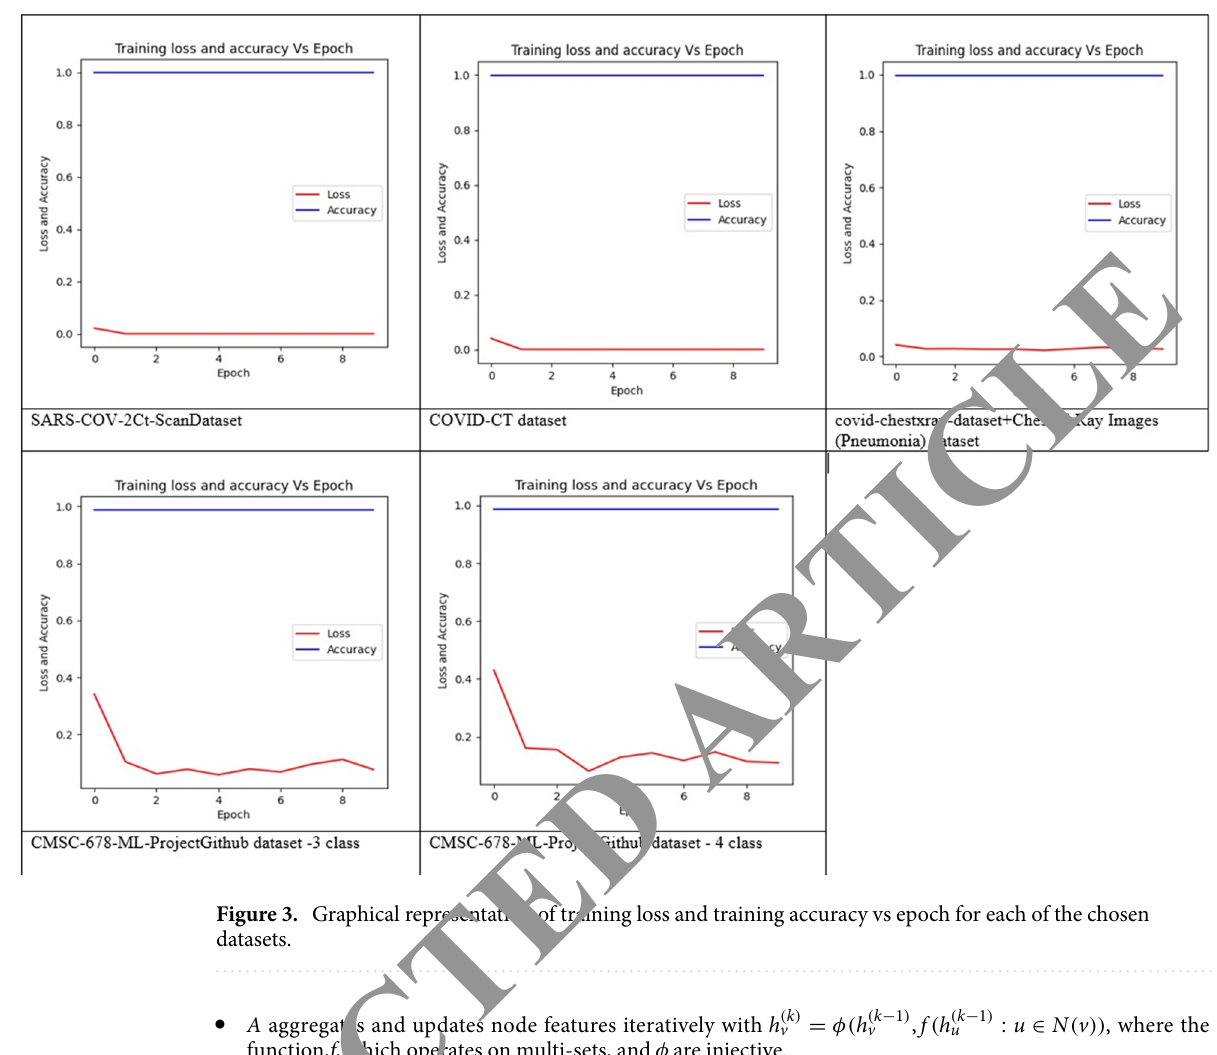
Figure 3. Graphical representation of training loss and training accuracy vs epoch for each of the chosen